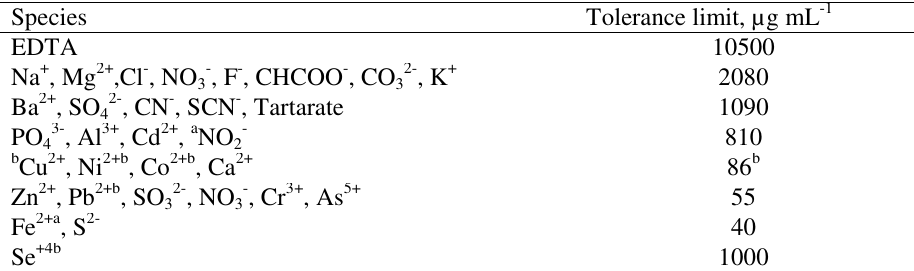
Effect of foreign species on the determination of 3 µg mL -1 tellurium with Leuco methylene green